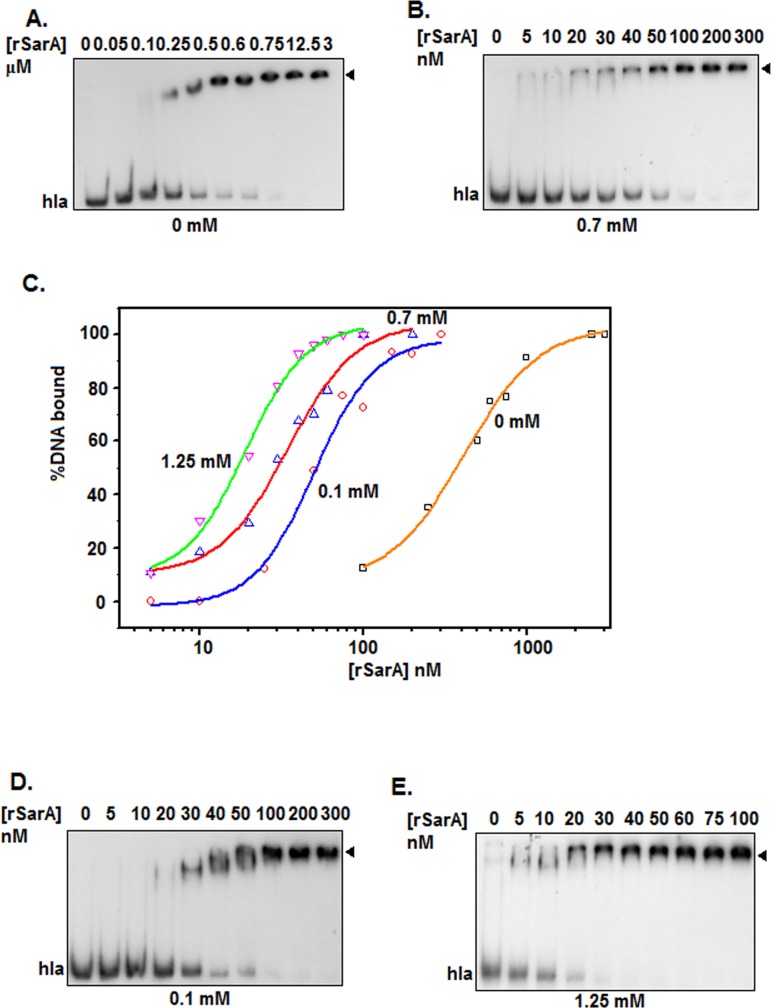
Gel shift assay in the presence of varying concentrations of TX-100.Autoradiograms show the equilibrium binding of rSarA to the 32P-labeled hla DNA in the presence of 0 mM (A), 0.7 mM (B), 0.1 mM (D), and 1.25 mM (E) TX-100. Arrowhead indicates the rSarA-hla DNA complex. All of the assays are performed at least three times. A set of autoradiograms are shown here. (C) rSarA DNA binding affinity. The amounts of rSarA bound to hla DNA in the presence of indicated concentrations of TX-100 are determined (using the data from the above autoradiograms) and plotted against the corresponding rSarA concentrations.